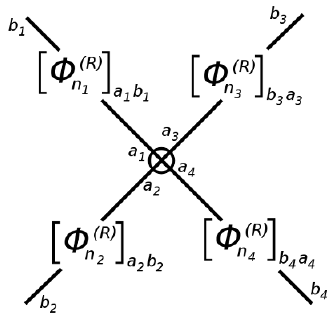
Figure 1 . Representation of the amplitude involving four Wilson